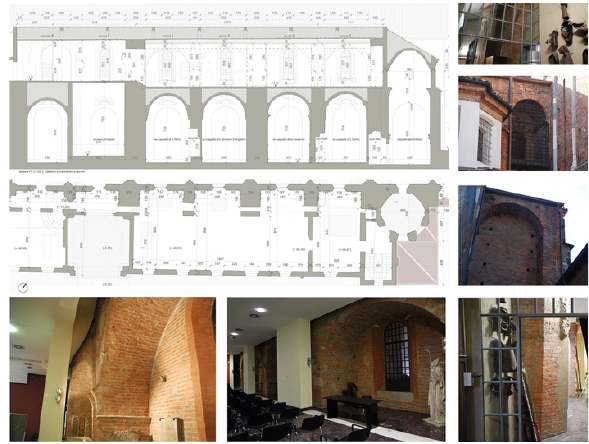
Figure 1. Section, plan and pictures of the northern arch structure of Basilica of Sant’Ambrogio in Milan.